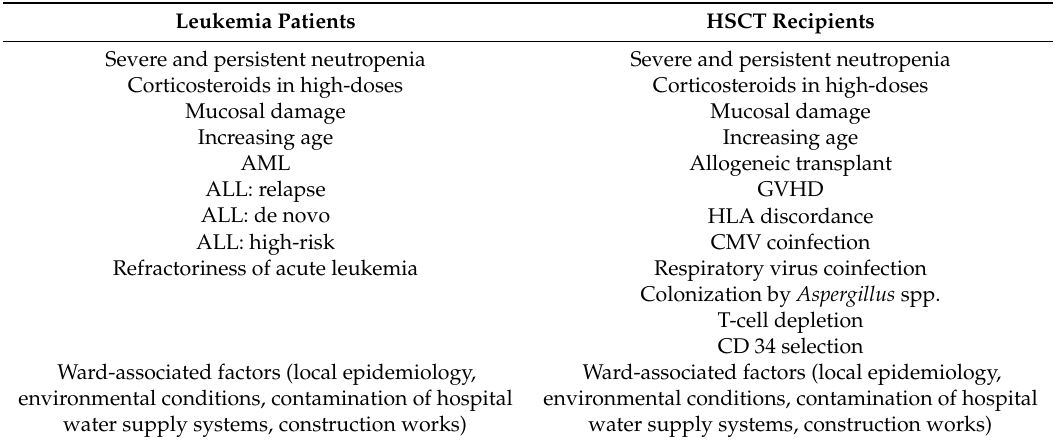
Table 2. Risk factors for Invasive Aspergillosis in pediatric